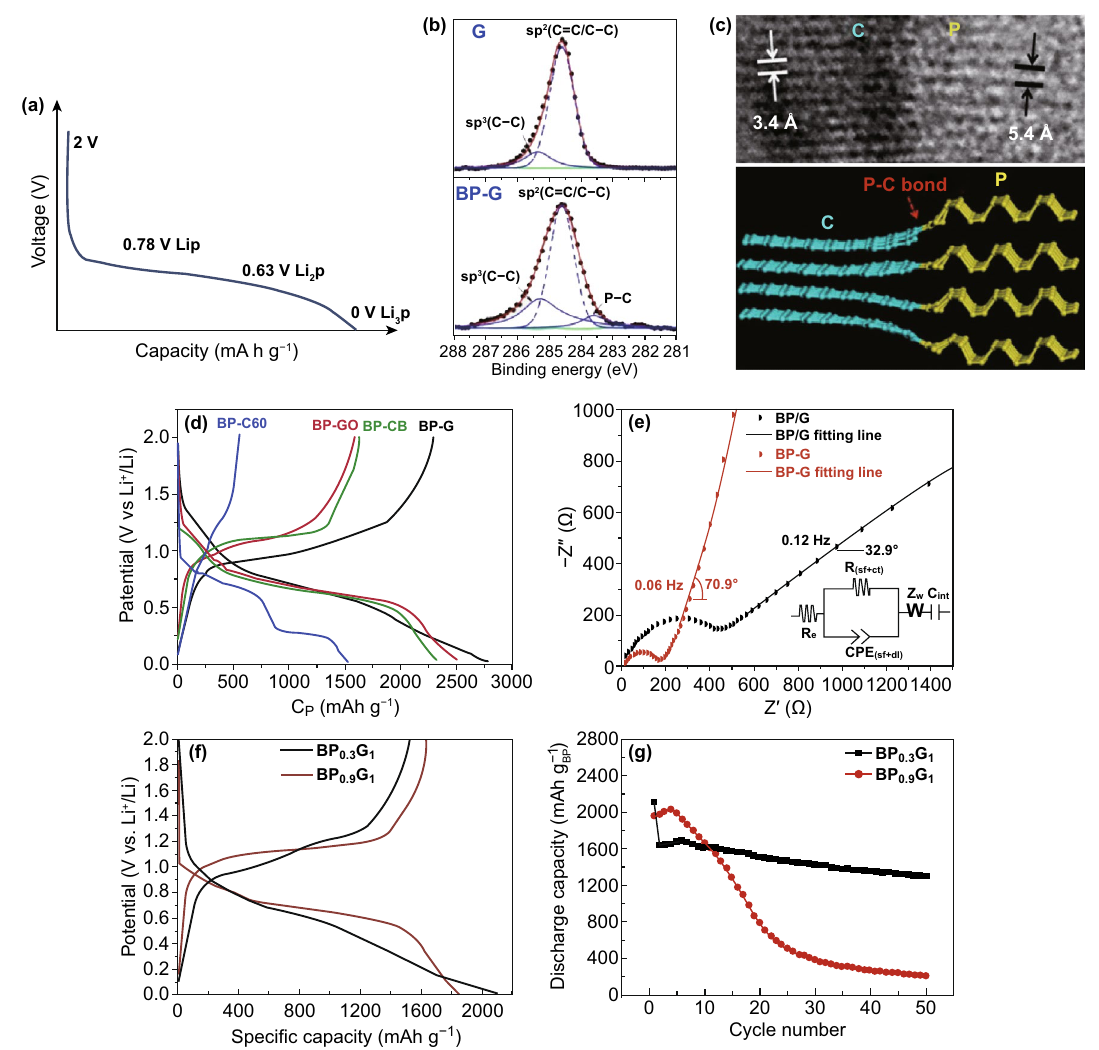
Fig. 7 a The multistep lithiation process of phosphorene [127]. b XPS of G and BP-G composition, c A P–C bonding type in BP-G composi- tion, d First charge/discharge curves of four anode materials (BP-C 60 , BPGO, BP-CB and BP-G) at 0.2C ratio, e EIS of BP-G composite and BP/G mixture [136]. f The first discharge–charge profiles and g cycle performance of BP 0.3 -G 1 and BP 0.9 -G 1 [138]. Adapted from Refs. [127, 136, 138] with